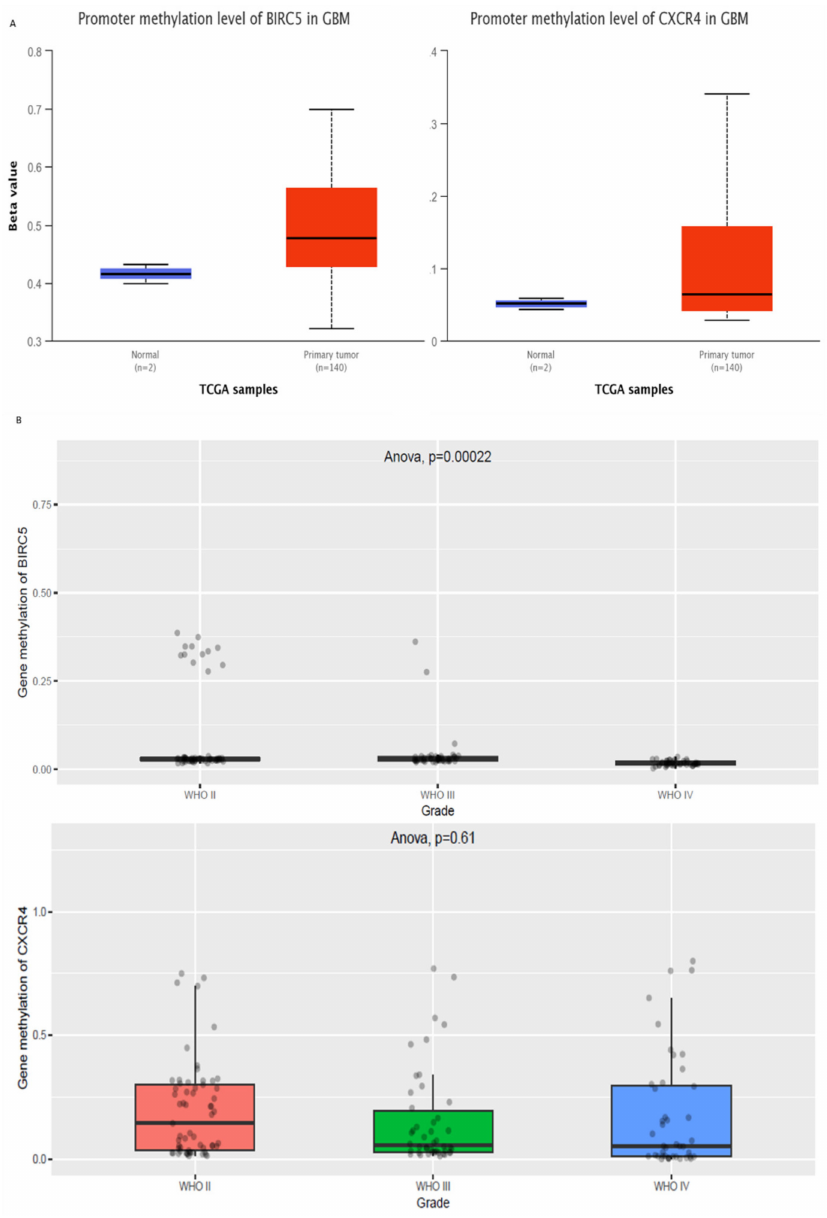
Figure 2. Methylation profile of BIRC5 and CXCR4. ( A ) Promoter methylation levels from TCGA nor- mal and tumour samples ( B ) Methylation profile in different grades of glioma from CCGA